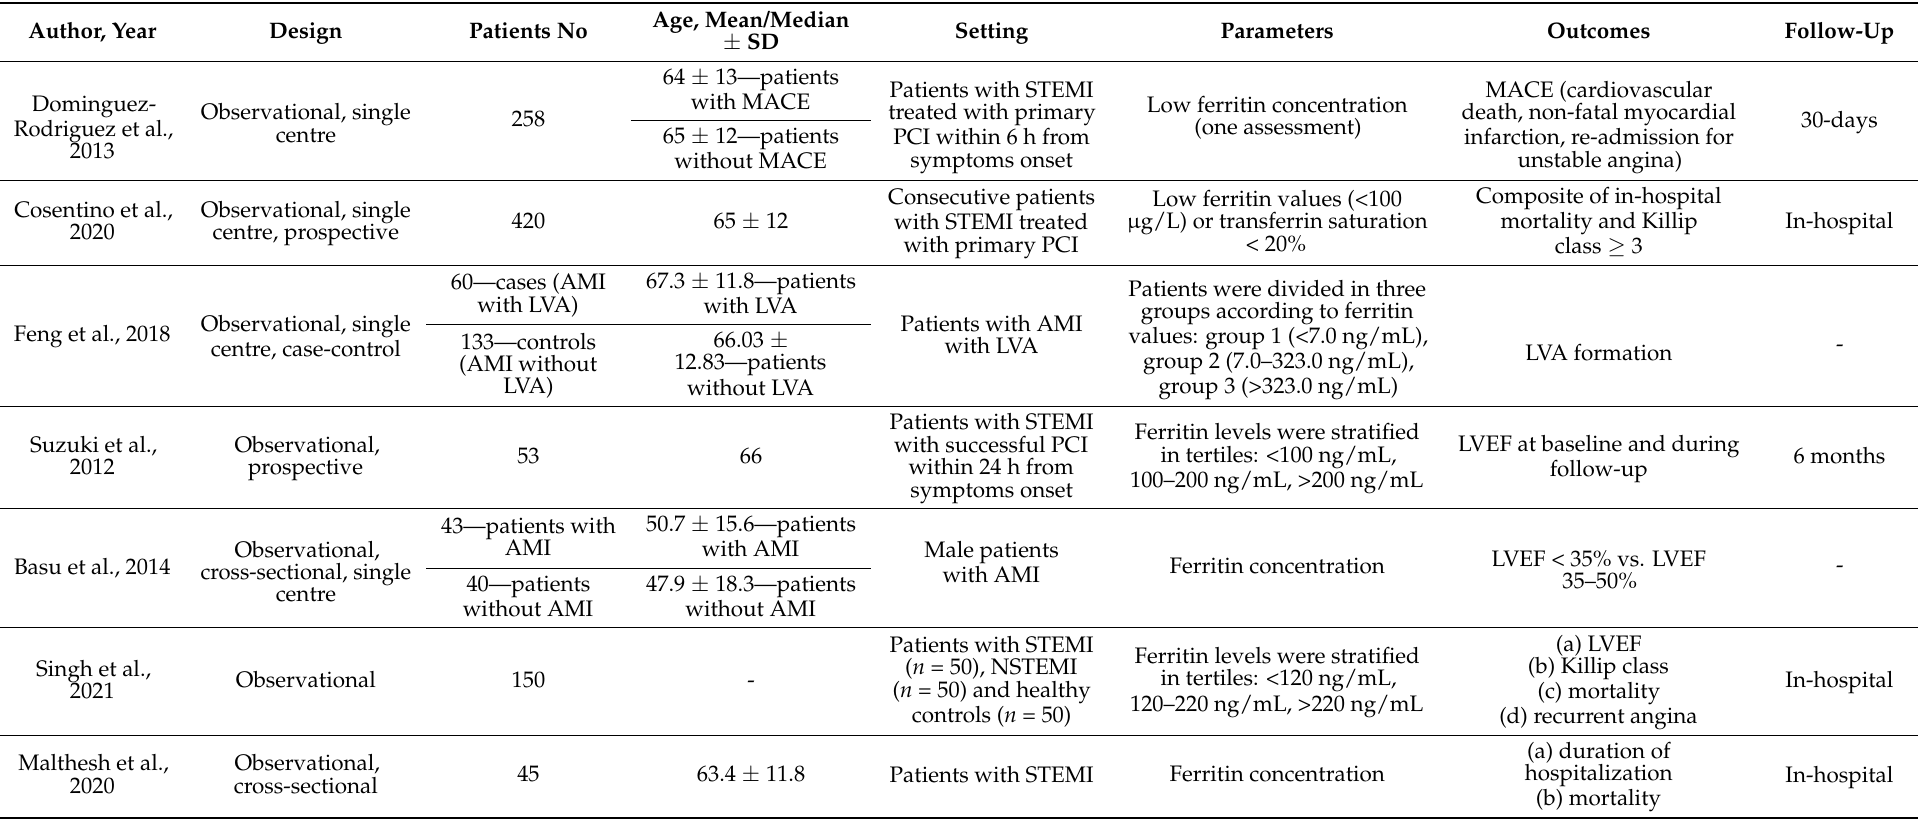
Table 1. General characteristics of studies included in present systematic